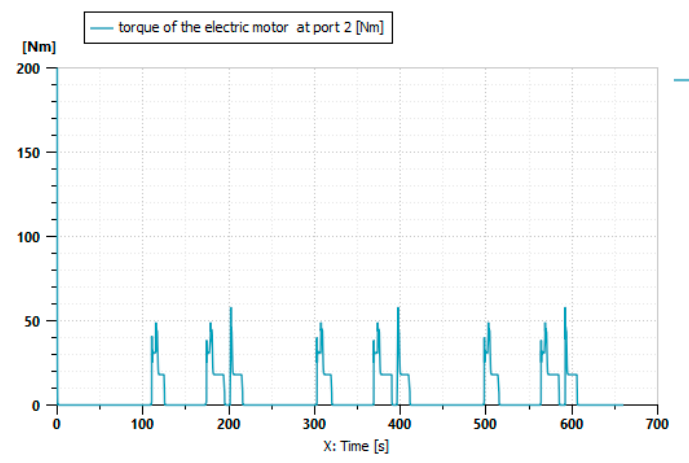
Figure 19. Electric motor torque.